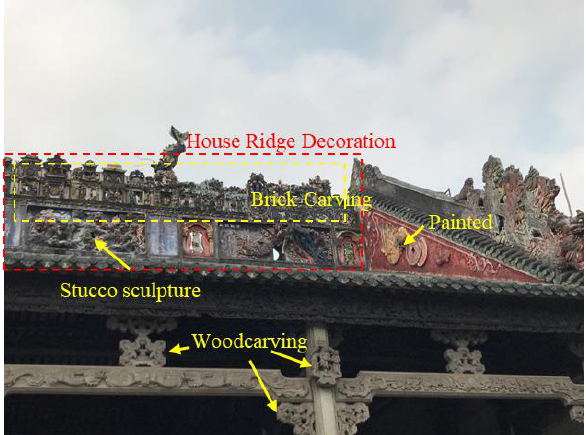
Figure 16. Artistic elements at Chen Clan Temple.